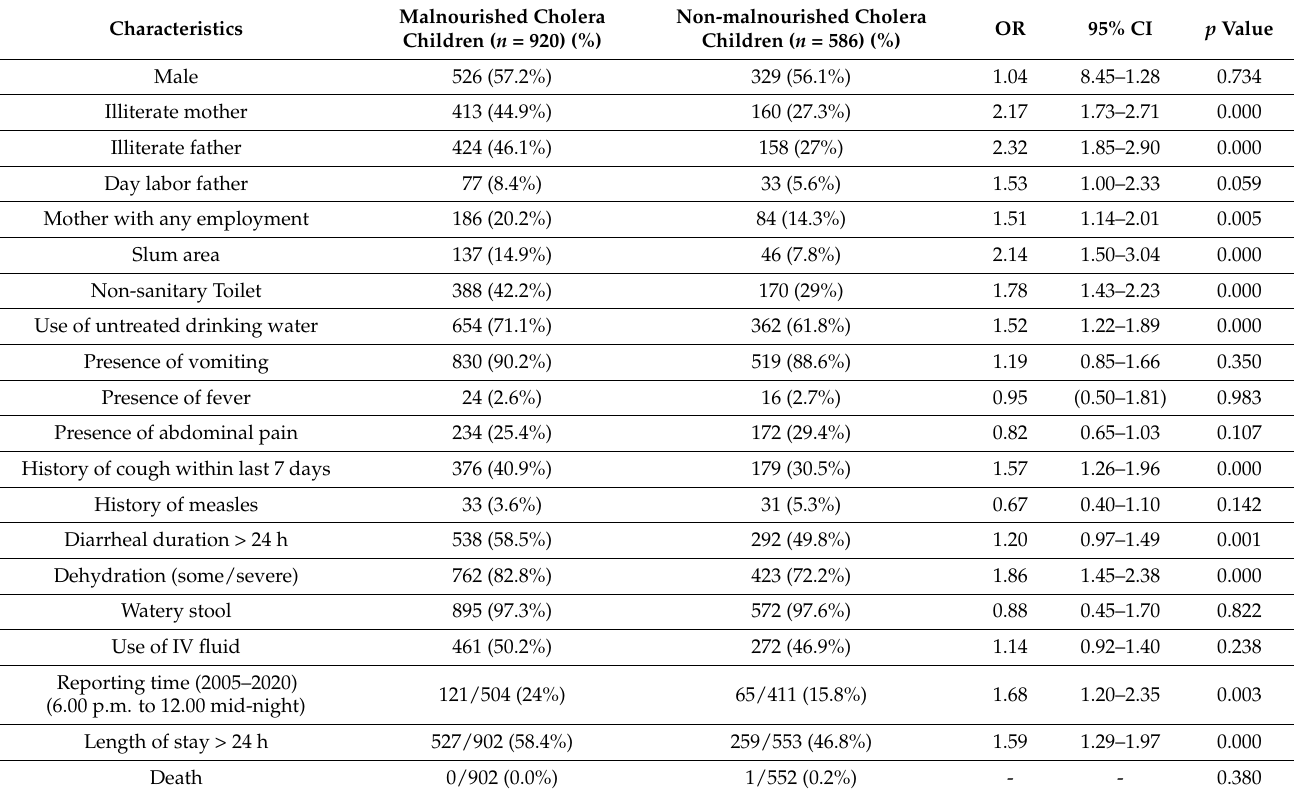
Table 1. Socio-demographic and clinical findings of cholera children without or with malnutrition in Bangladesh